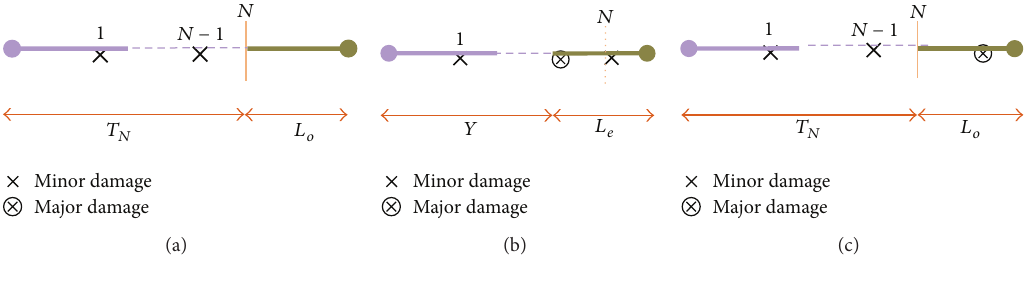
Figure 2: Three cases of an NDPM